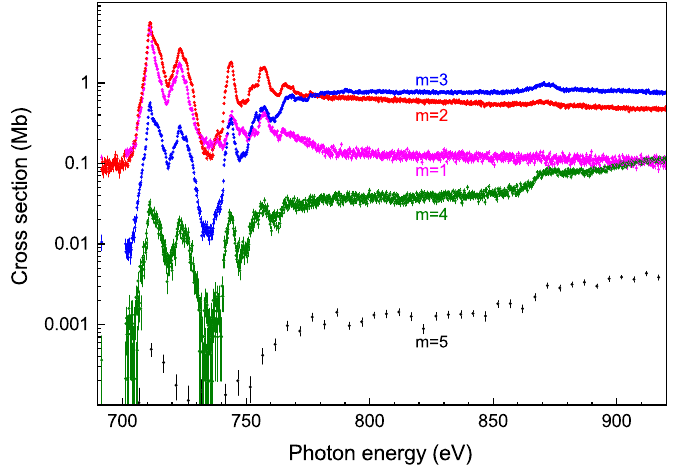
Figure 3. Experimental cross sections (1 Mb = 10 − 18 cm 2 ) for m -fold ionization of Fe 3 + ions in the energy range 690–920 eV that contains the thresholds for 2 p and 2 s ionization [39]. The observed resonance structures are associated with the excitation of a 2 p or a 2 s electron to a higher atomic subshell and subsequent